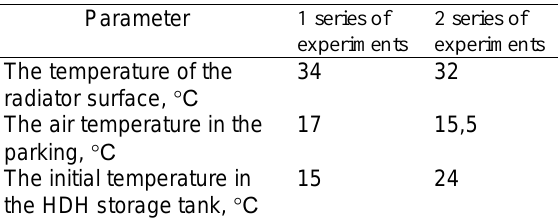
Table 1. Additional initial data for the